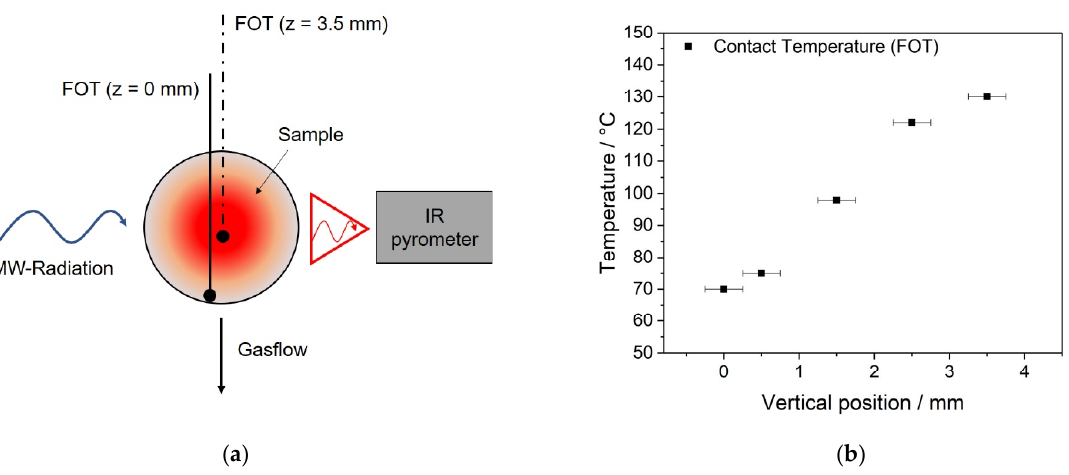
Figure 2. ( a ) Schematic representation of the spherical quartz reactor with catalyst filling and a MW ‐ induced thermal gradient indicated by color. ( b ) Real thermal gradient determined by FOT contact measurement in an LSC ‐ 82 powder bed exposed and controlled to MW radiation with a fixed set temperature of 70 °C by an IR ‐ pyrometer.